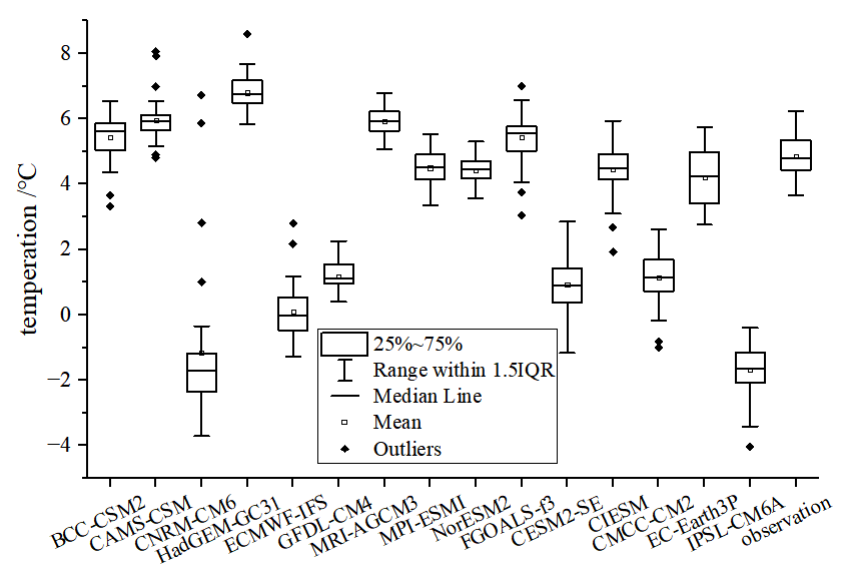
Figure 2. Box plot of the temperature simulations of each CMIP6 model.